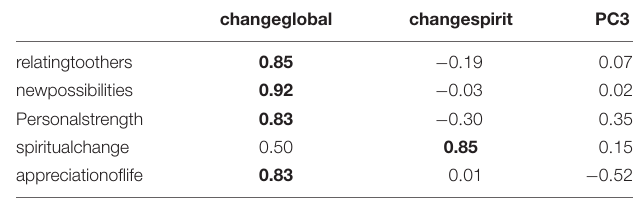
TABLE 5 | PCA relative to PTGI